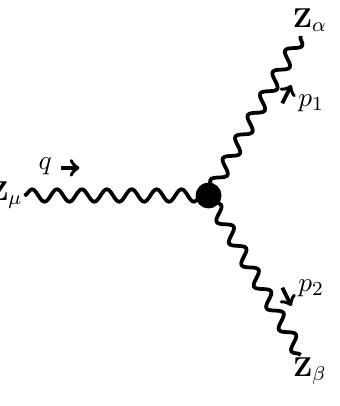
Figure 1 . Conventions for the ZZZ vertex (cid:0)